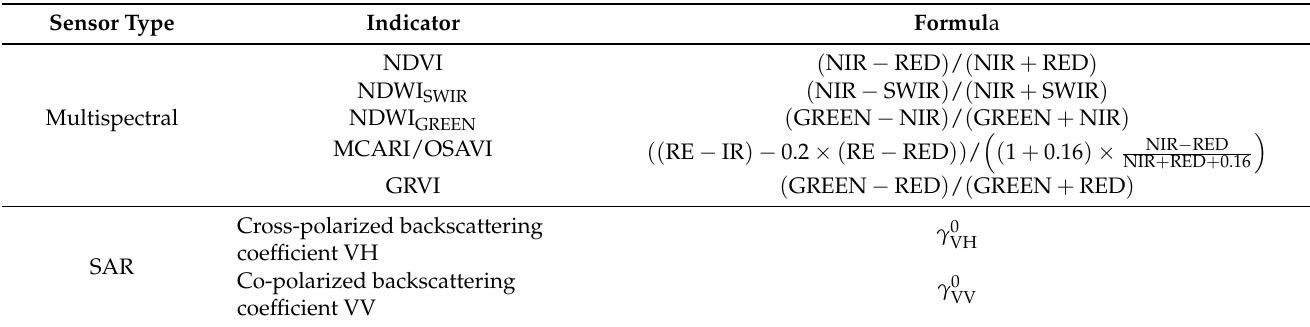
Table 2. Pixel-level features computed from S2 and S1 images used in this paper. For S2, The near infrared (band 8), red edge (band 5), short wave infrared (band 11), green (band 3) and red (band 4) channels are denoted as NIR, RE, SWIR, GREEN and RED,